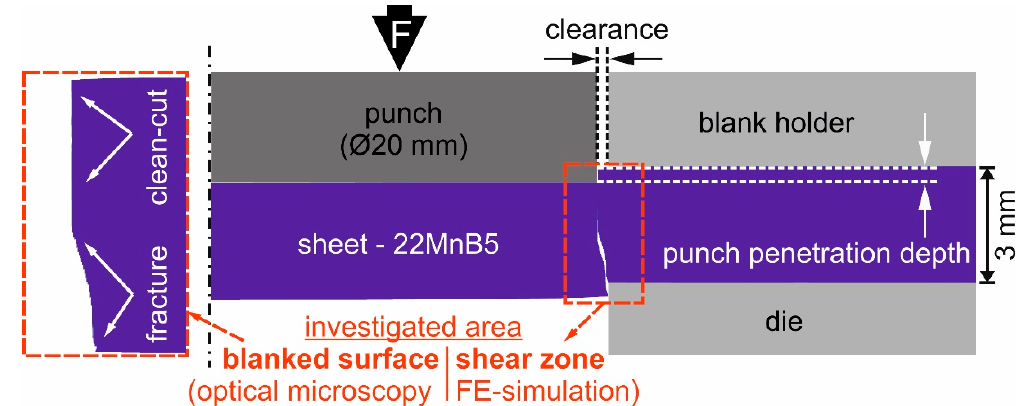
Figure 2. Two-dimensional model for the numerical calculation of the stress triaxiality in the shear zone in LS-DYNA. Additionally, the investigated area (blanked surface) for the optical microscopy is schematically shown. Table 2. Investigated dies (sample designation) and the resulting blanking and relative